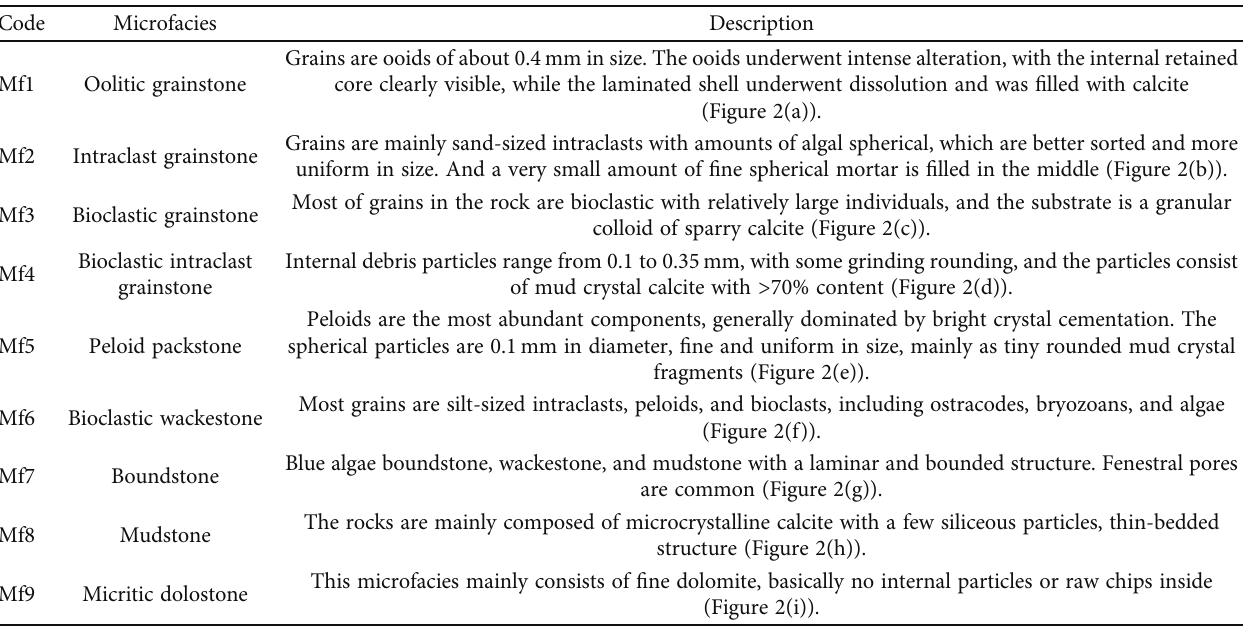
Table 1: Microfacies and sedimentary interpretation of Yingshan